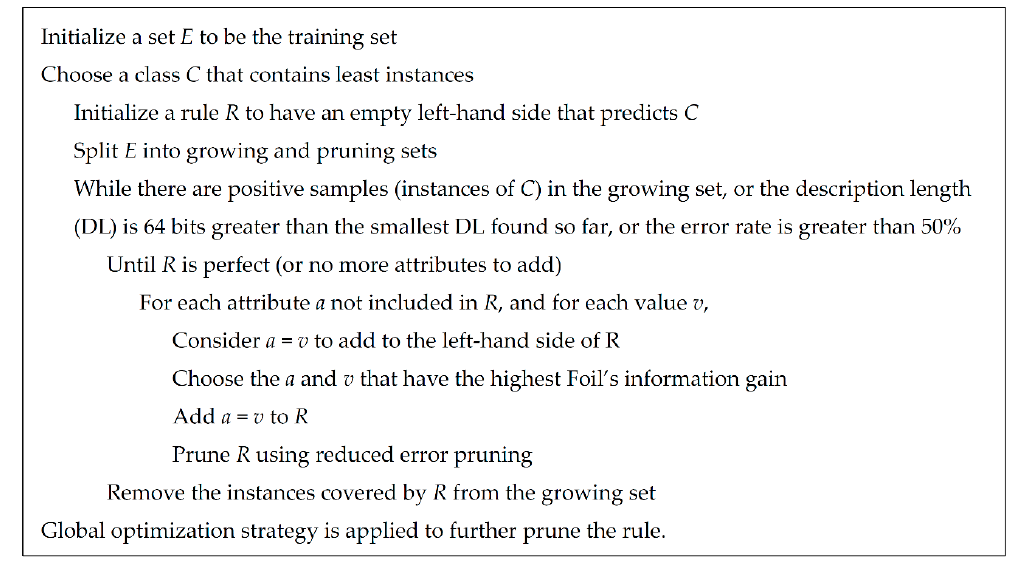
Figure 4. The rule learning procedures of repeated incremental pruning to produce error reduction (RIPPER) algorithm [85].